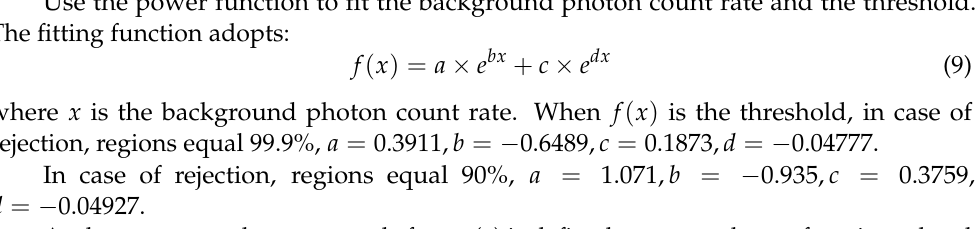
Figure 9. Model rejecting 99.9% and 90% probability distribution location.